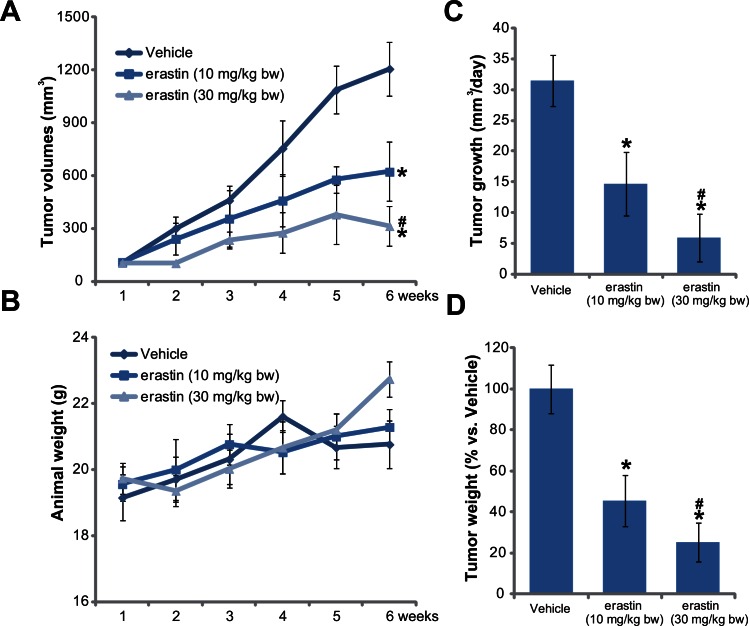
Erastin administration inhibits HT-29 xenograft growth in SCID mice.HT-29 tumor bearing SCID mice were intraperitoneally administrated with erastin (10/30 mg/kg body weight or “bw”, daily, for 4 weeks) or vehicle (Saline) control, tumor volumes (A) and mice body weights (B) were recorded weekly for five weeks; Daily tumor growth was also calculated (C). At the termination of experiments, all the xenografts were isolated and weighted (D). For each assay, n = 10. The data presented were mean ± SD. Experiments were repeated twice with similar results obtained. * p < 0.05 vs. group of “Vehicle”. # p < 0.05 vs. group of erastin at 10 mg/kg of body weight.